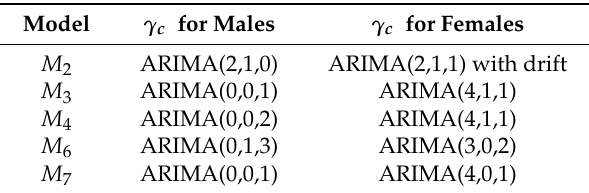
Table 5. Selected ARIMA(p,d,q) models for the cohort index γ c of male and female mortality